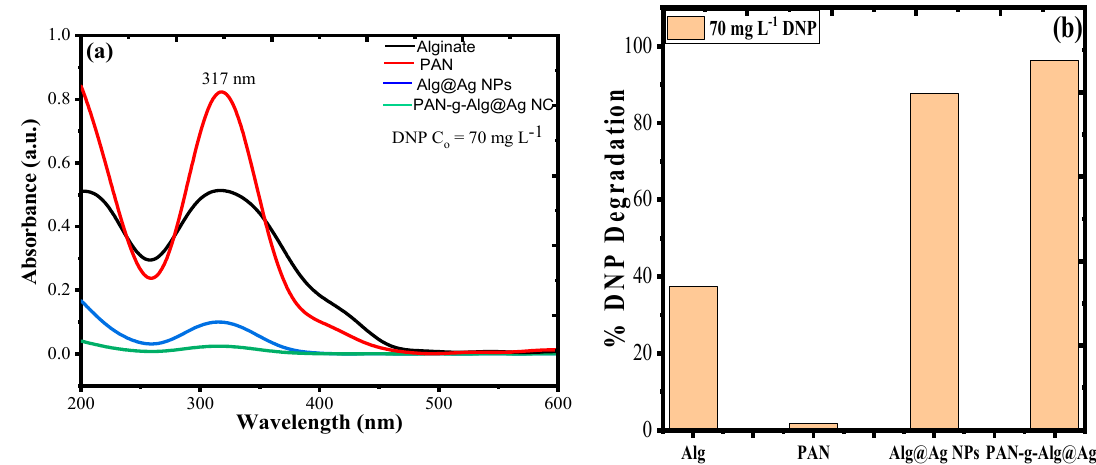
Figure 9. ( a ) UV–Vis plot for the photocatalytic activity of synthesized PAN-g-Alg@Ag NC and its individual constituents towards DNP; and ( b ) the corresponding percent degradation bar graph.